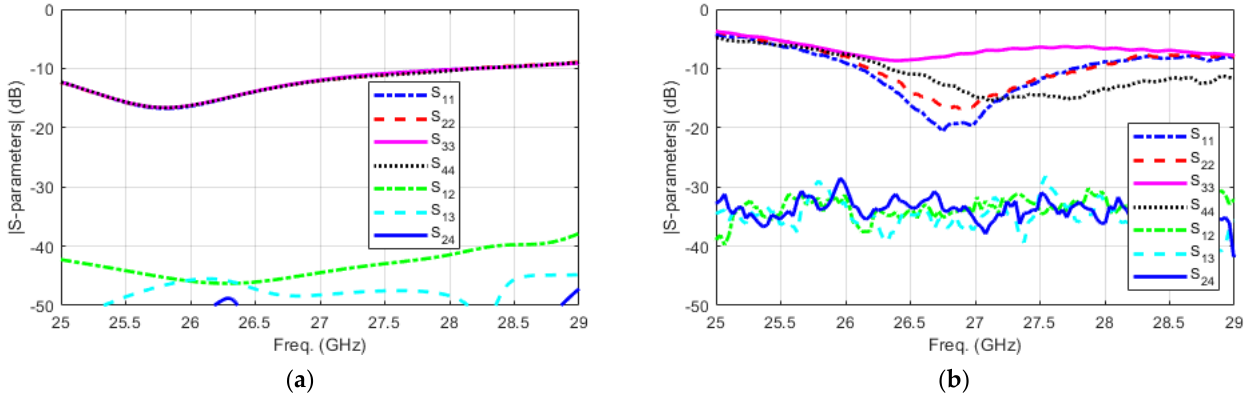
Figure 7. S − parameter curves for Ant.1 to Ant. 4 at 5G mm-wave band: ( a ) simulated and ( b ) meas- ured.